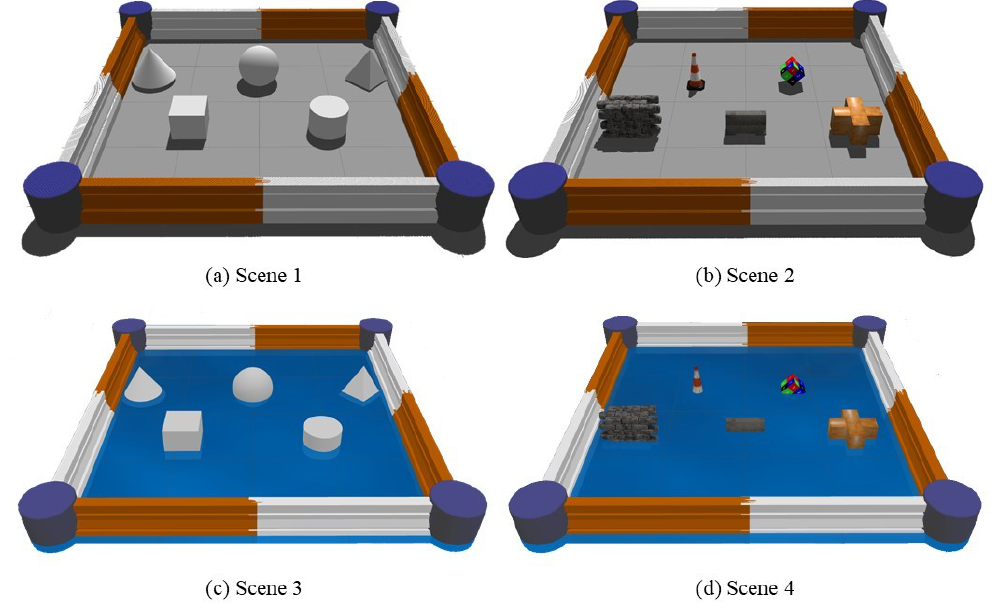
Figure 8. Test scenes. ( a ) Scene 1 contains obstacles that appeared during training; ( b ) Scene 2 contains unstructured obstacles that were not encountered during training. ( c ) Scene 3 has the same layout as Scene 1, except the UUV simulator was used to simulate the water environment. ( d ) Scenario 4 used the UUV simulator, unlike Scene